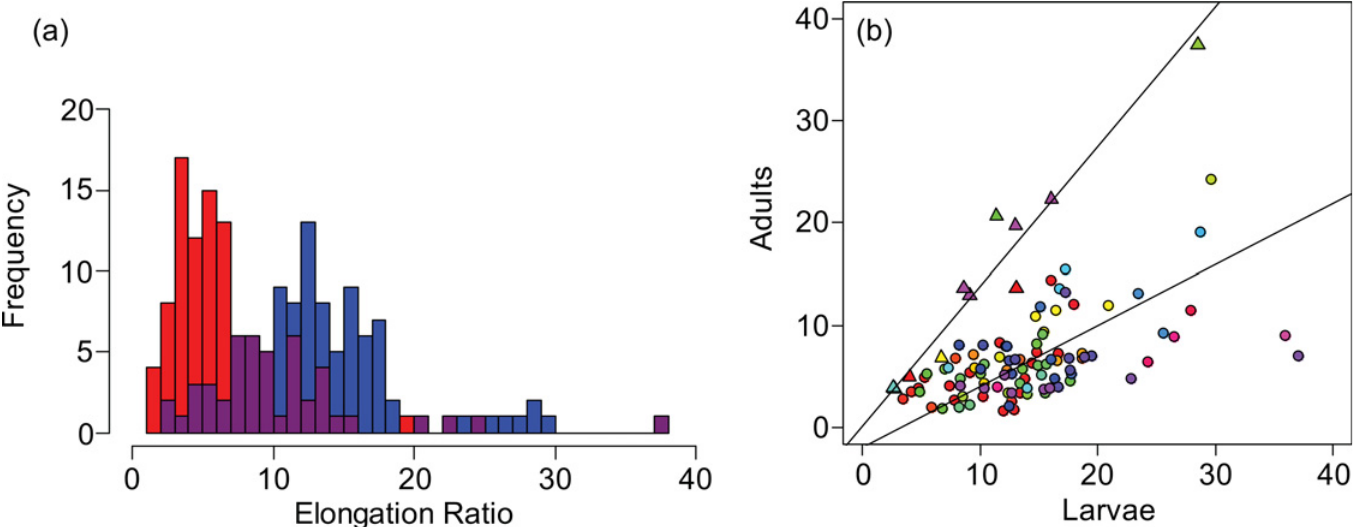
Fig 2. Comparison of larval and adult elongation ratios. (a) The distribution of larval (blue) and adult (red) elongation ratios. The number of species (x- axis) observed for a given elongation ratio (y-axis). (b) Larval elongation ratio plotted against adult elongation ratio. Each point represents a single species and colors correspond to the orders as presented in Fig 1. The regression line is plotted for species that demonstrated a decrease in elongation ratio through ontogeny (circles) as well as for those species that demonstrated an increase in elongation ratio (triangles). Colors correspond to the orders as presented in Fig 1.